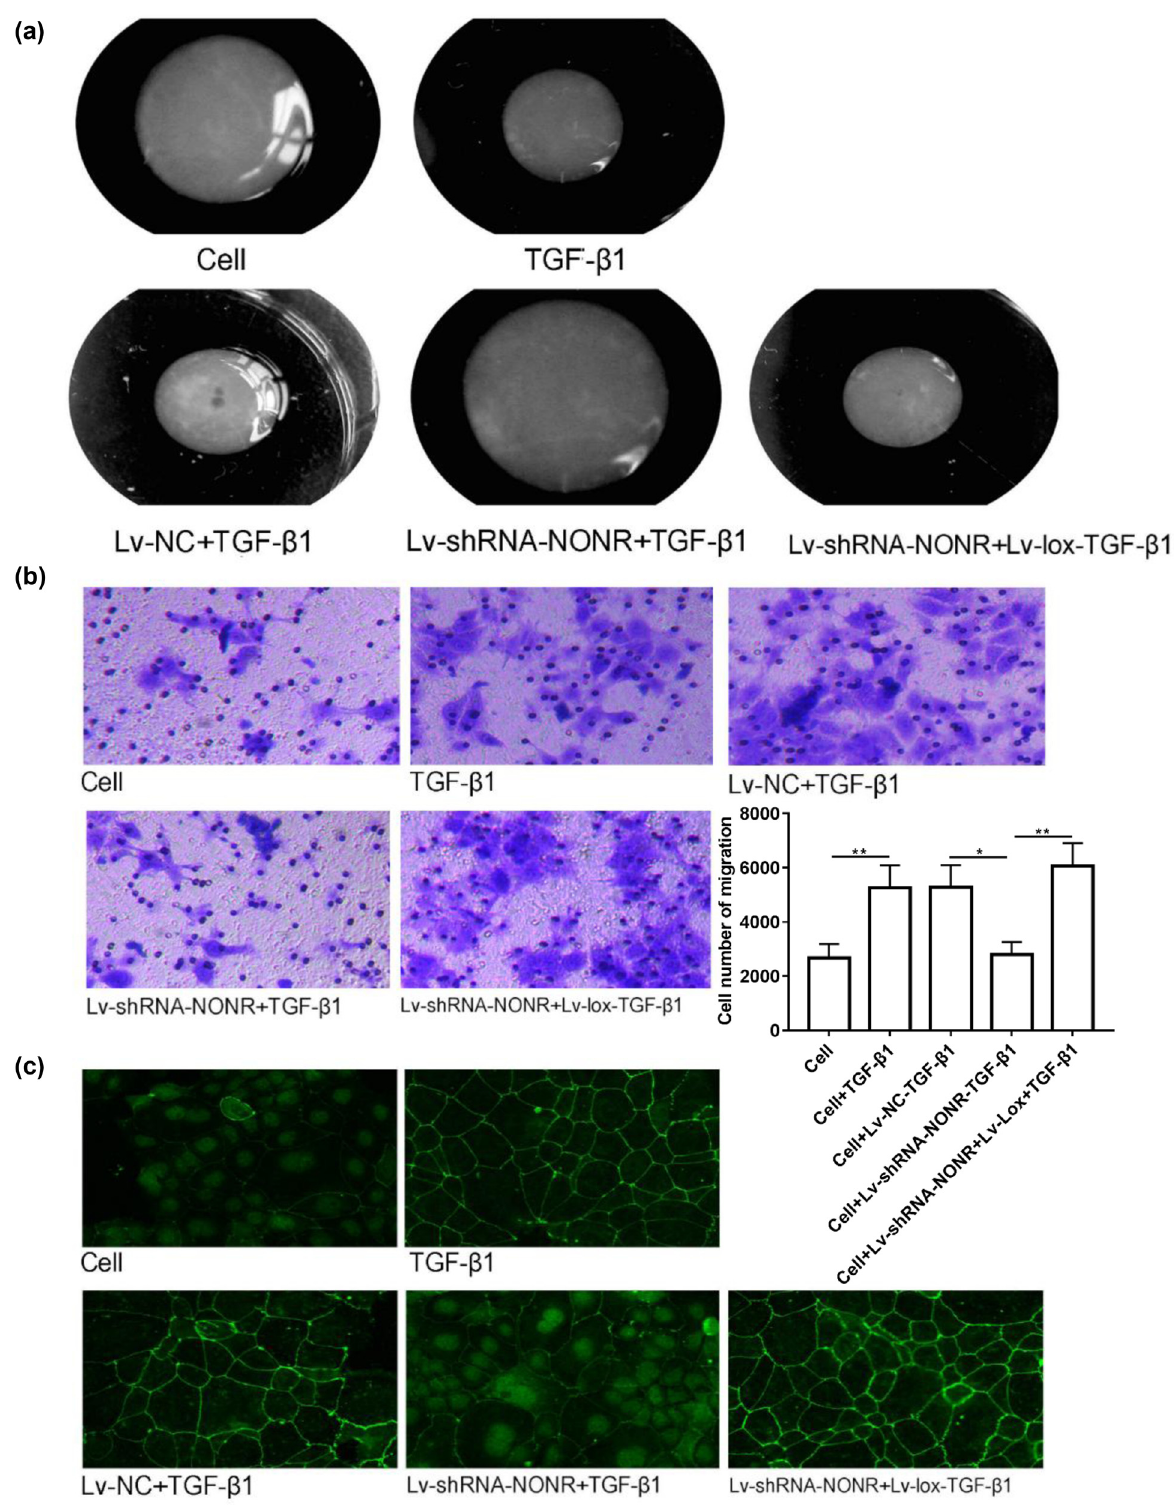
Figure 6: Silencing NONRATT013819.2 inhibited ECM reconstruction through Lox. ( a ) Contraction of hydrated collagen gels induced in HSCs. ( b ) The migration of HSCs was detected by the Transwell method. ( c ) Immuno fl uorescence staining of α - SMA protein in HSCs. The results were expressed as the mean ± SD from three independent experiments, * P < 0.05, ** P <